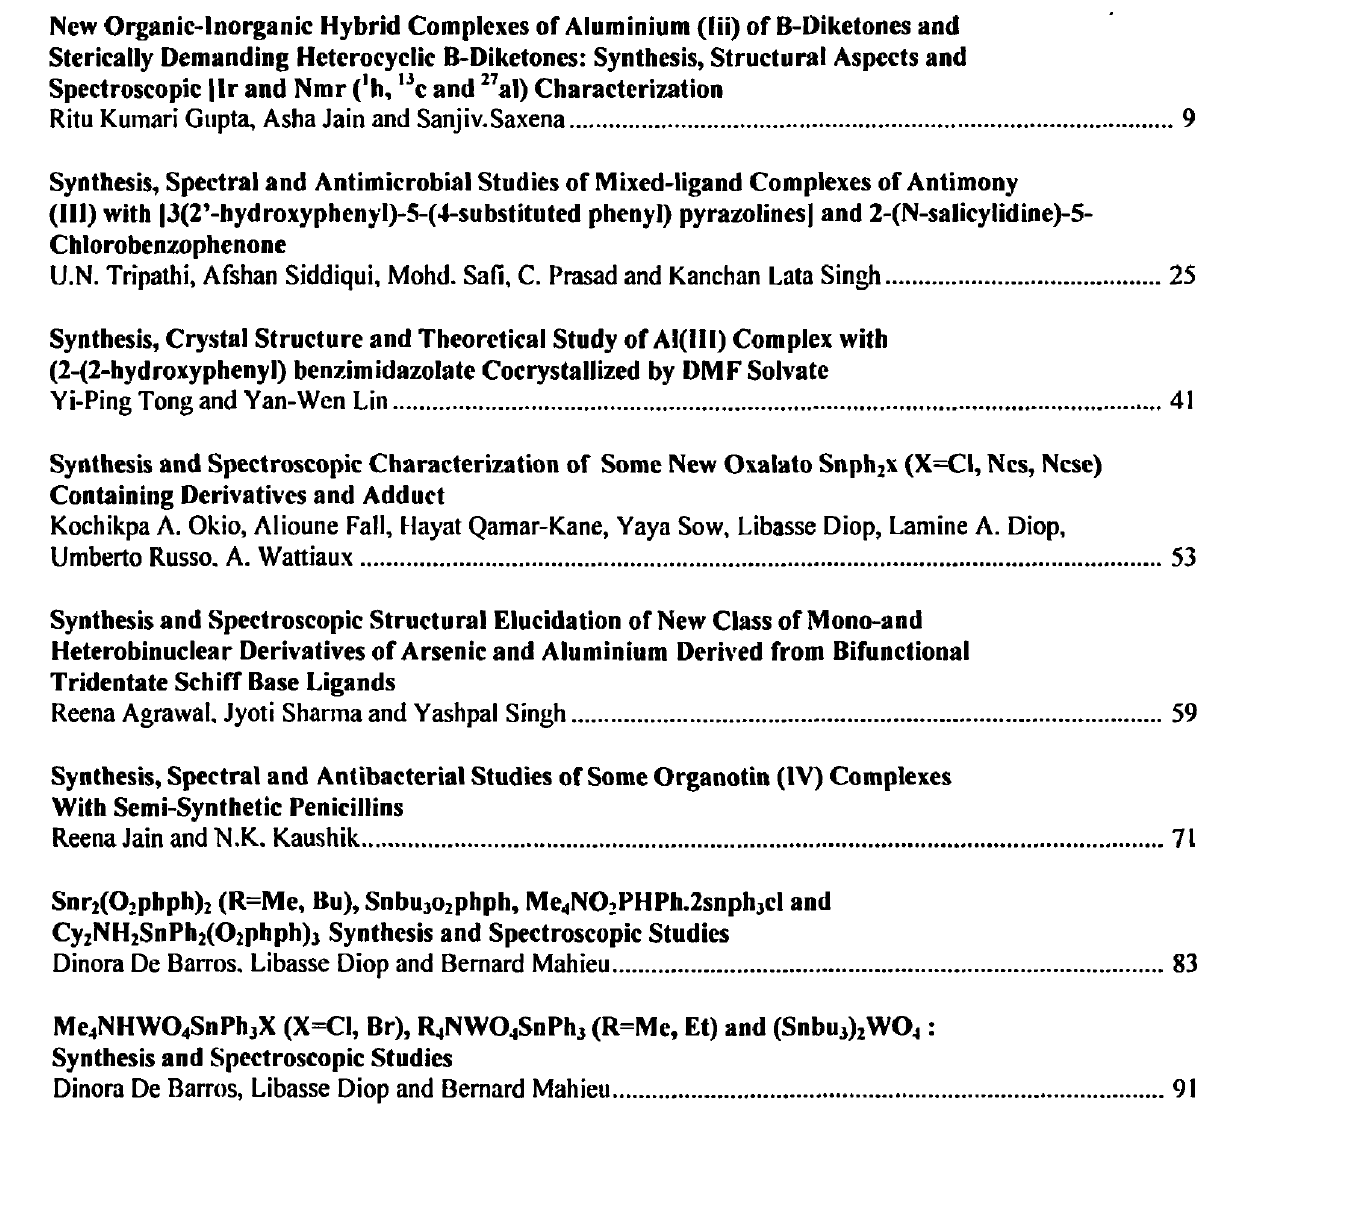
Nitrogen Oxygen Bonded Heterocyclic Organotin (IV) Derivatives of a New Schiff Base: Synthesis and Spectral Aspects